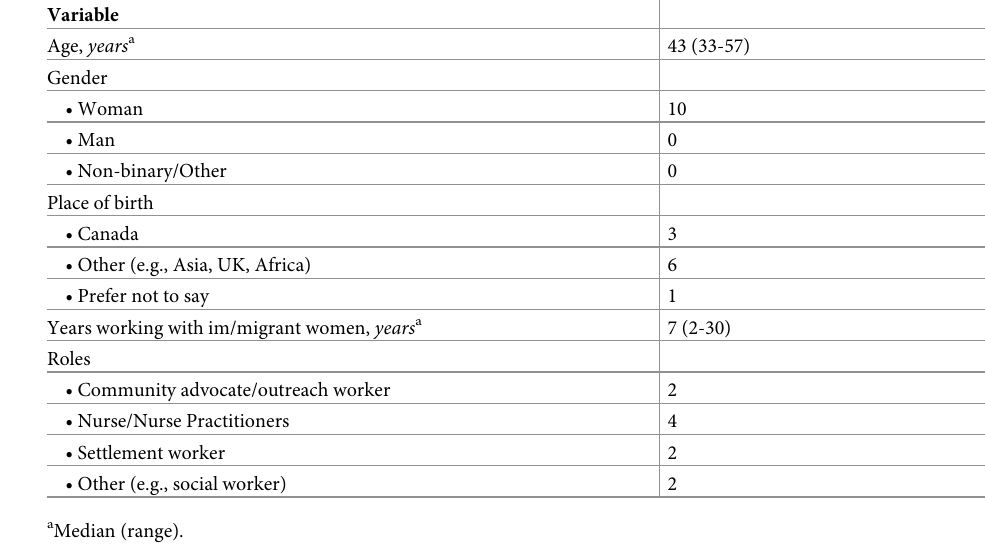
Table 2. Service providers: Participant characteristics (N = 10).